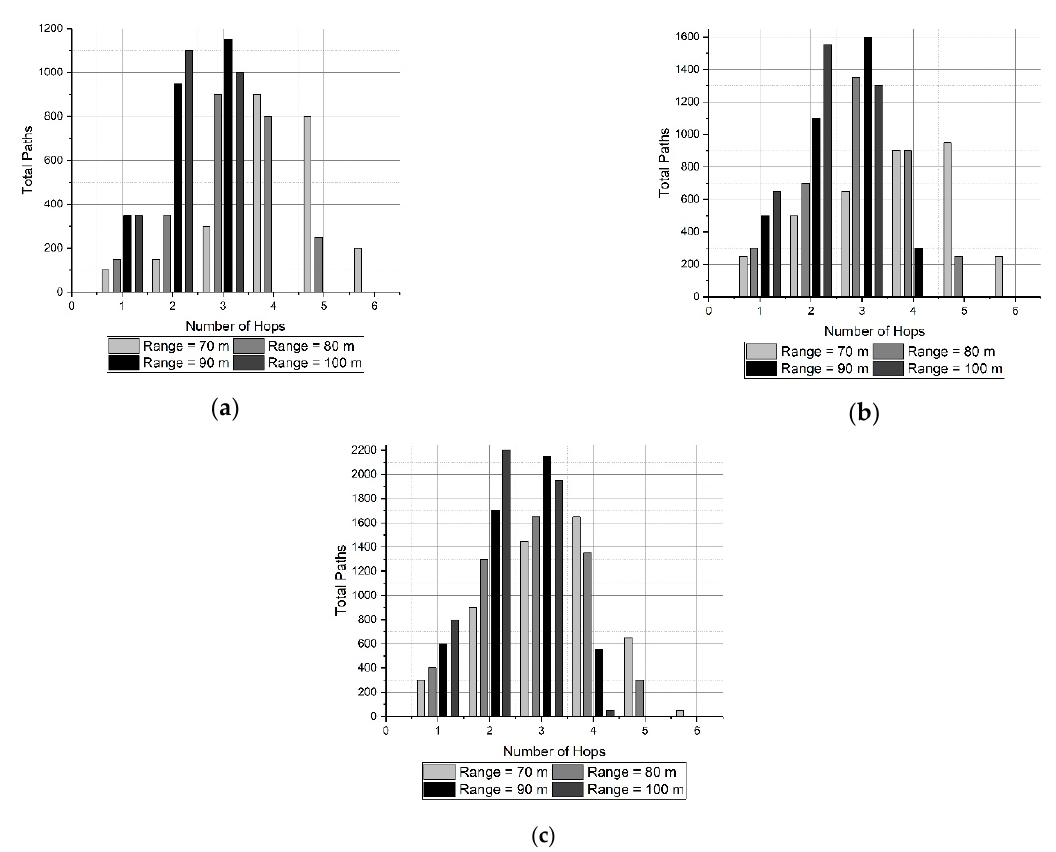
Figure 19. Number of hops in each path vs transmission range for three network sizes: ( a ) 50, ( b ) 70, ( c ) 100.